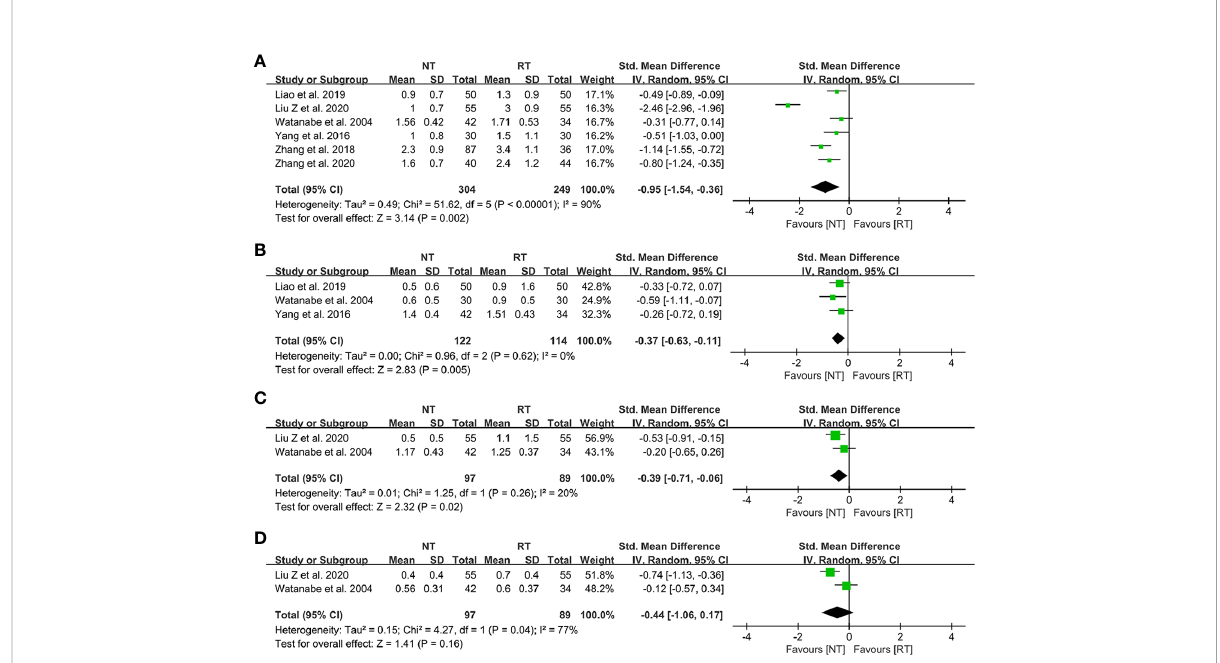
FIGURE 5 Meta-analysis of postoperative pain score between the NT and RT groups. (A) POD 1; (B) POD 2; (C) POD 3; (D) POD 7. NT, no routine chest tube drainage; RT, routine chest tube drainage; POD, postoperative day; CI, con fi dence